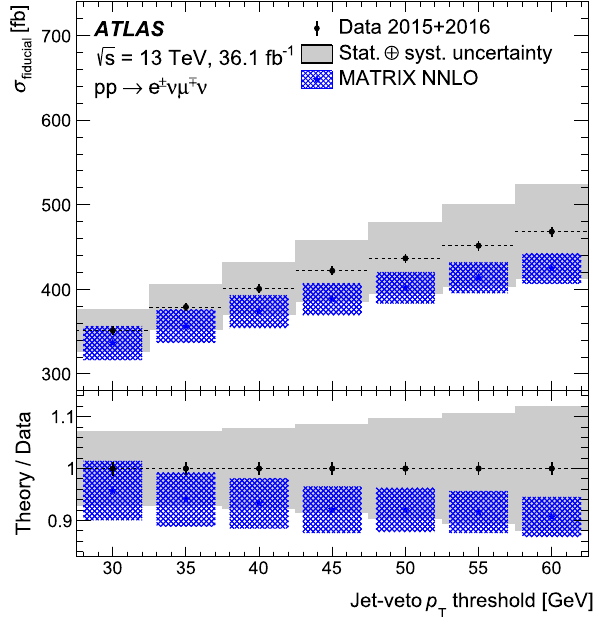
Fig. 6 Comparison of the measured fiducial cross-section as a func- tionofthejet-veto p T thresholdwithvarioustheoreticalpredictions.The measurement is compared with NNLO predictions from MATRIX on theleft.ThiscalculationdoesnotincludetheNLOEWcorrectionandis Born-level, whilst the measurement is conducted using dressed leptons, which might account for some of the differences seen. On the right a comparison with NLO+PS predictions from Powheg- Box + Pythia 8, Powheg- Box + Herwig++ and Sherpa 2.2.2for q ¯ q initialstates,com-